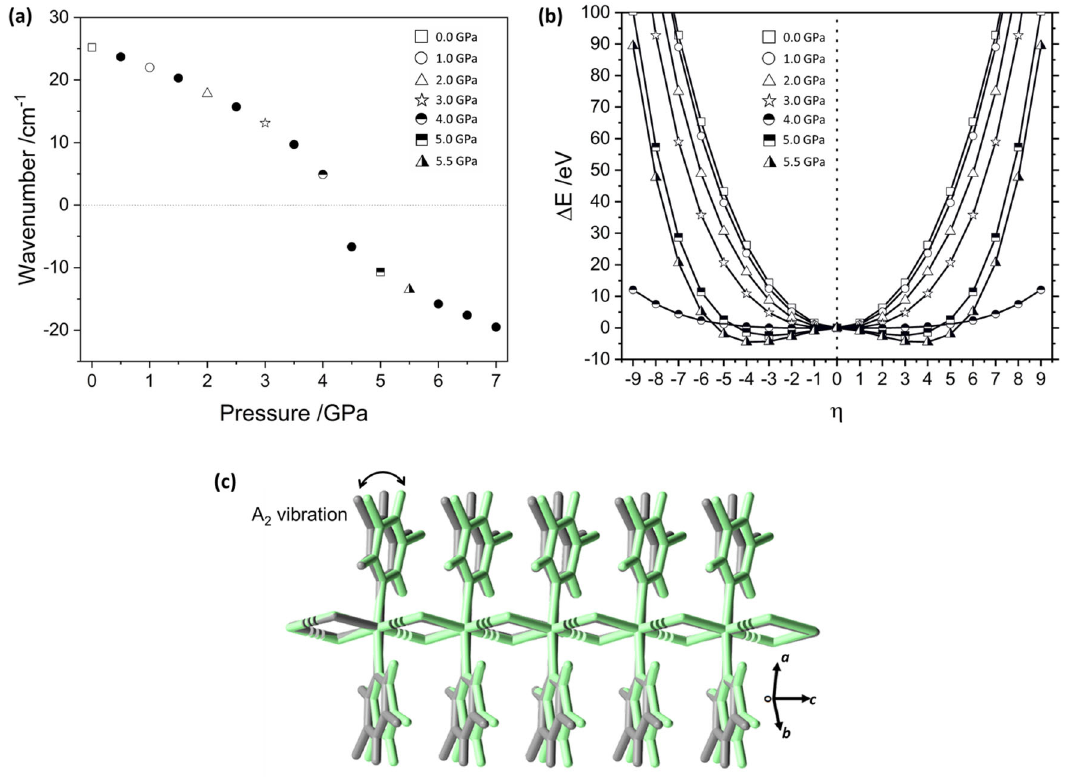
Fig. 4 Mode softening of the lowest frequency A 2 vibrational mode in (1) with pressure. a Vibrational frequency of the A 2 band as a function of pressure. b Potential energy surface associated with the lowest frequency A 2 normal mode in the low-pressure phase of ( 1 ). Displacements are shown as regular displacements along the A 2 mode eigenvector away from equilibrium. Note that the curves for P = 5 GPa and P = 5.5 GPa have been multiplied by 10 for clarity. c Overlay of the A 2 normal mode displacement from (grey) η = 0 to (green) η =